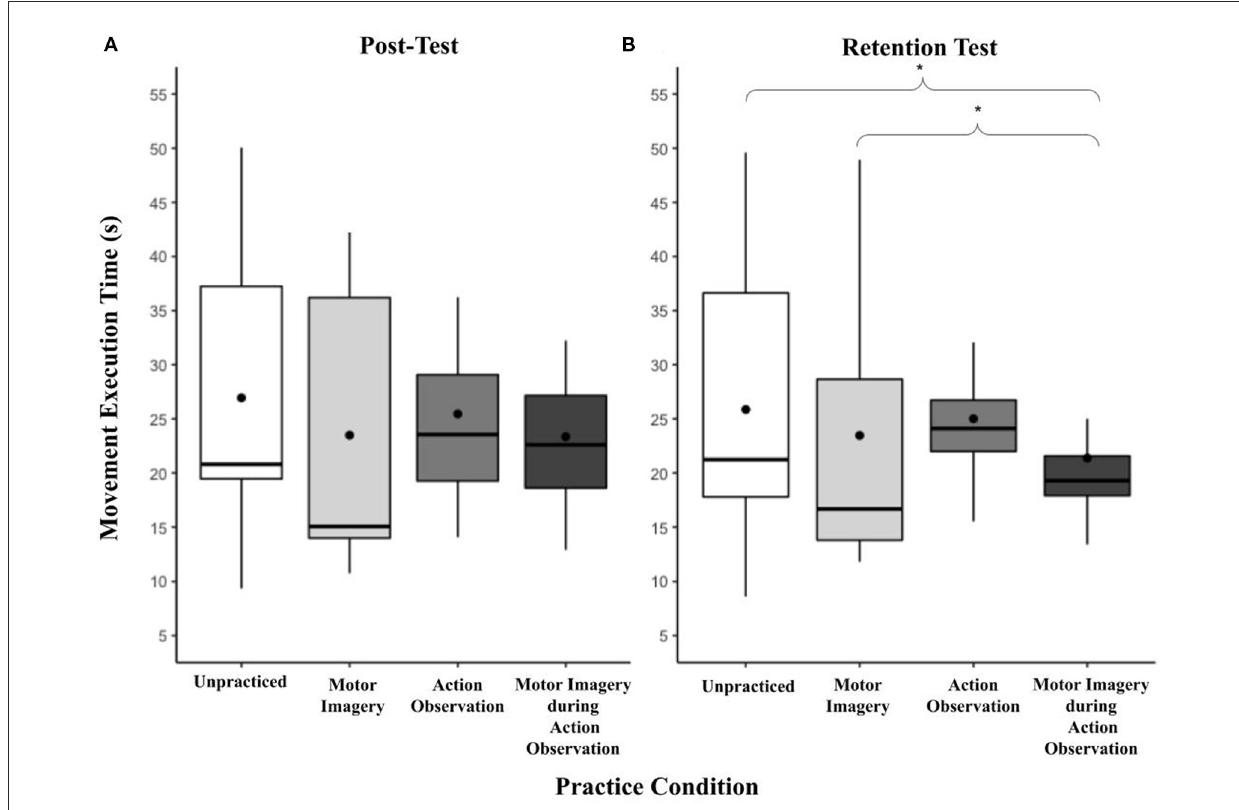
FIGURE4 (A, B) Box and whisker plot displaying movement execution times at post and retention for practice condition. This figure shows the distribution of movement execution time data and skewness for all practice conditions at the post and retention test time points. These data are presented by displaying a six-number summary including: the minimum score (bottom of lowest line), first (lower) quartile (lower line), median (black horizontal line), third (upper) quartile (upper line), mean (black dot) and maximum score (top of upper line); * p < 0.05.